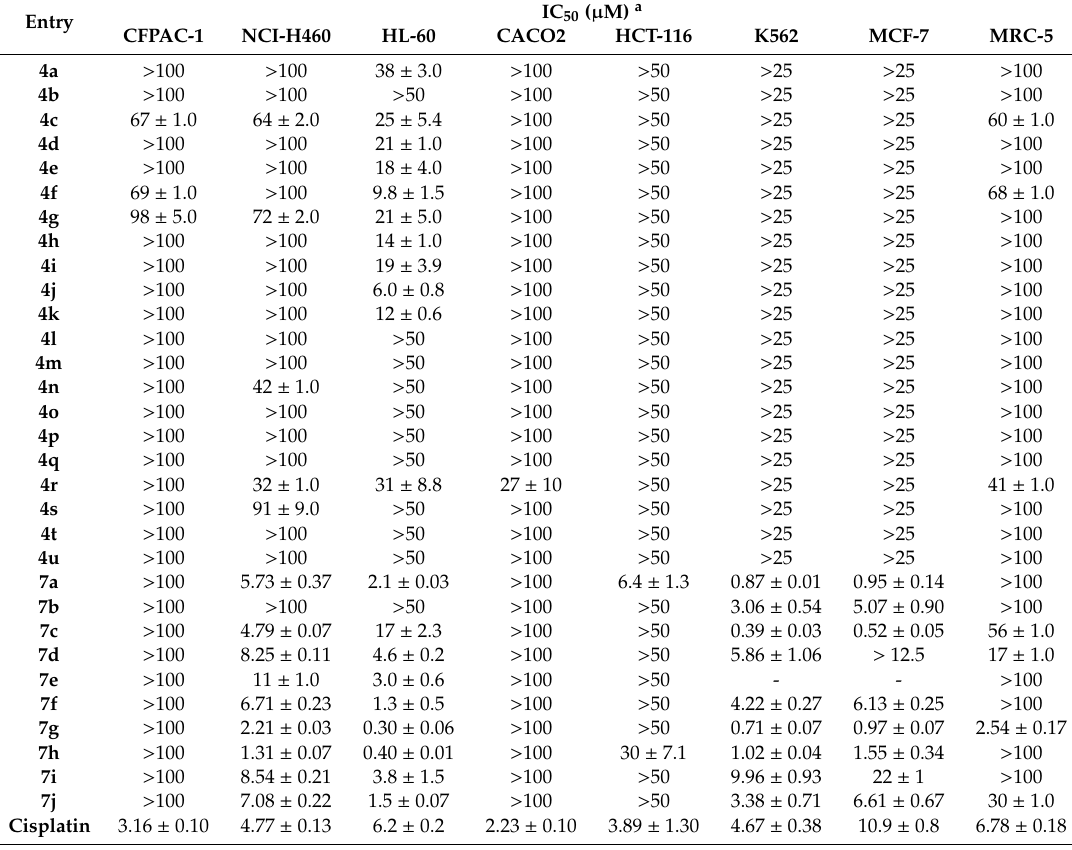
Table 1. In vitro cytotoxicity of compounds 4a – u and 7a – j on cancer and MRC-5 cell lines.